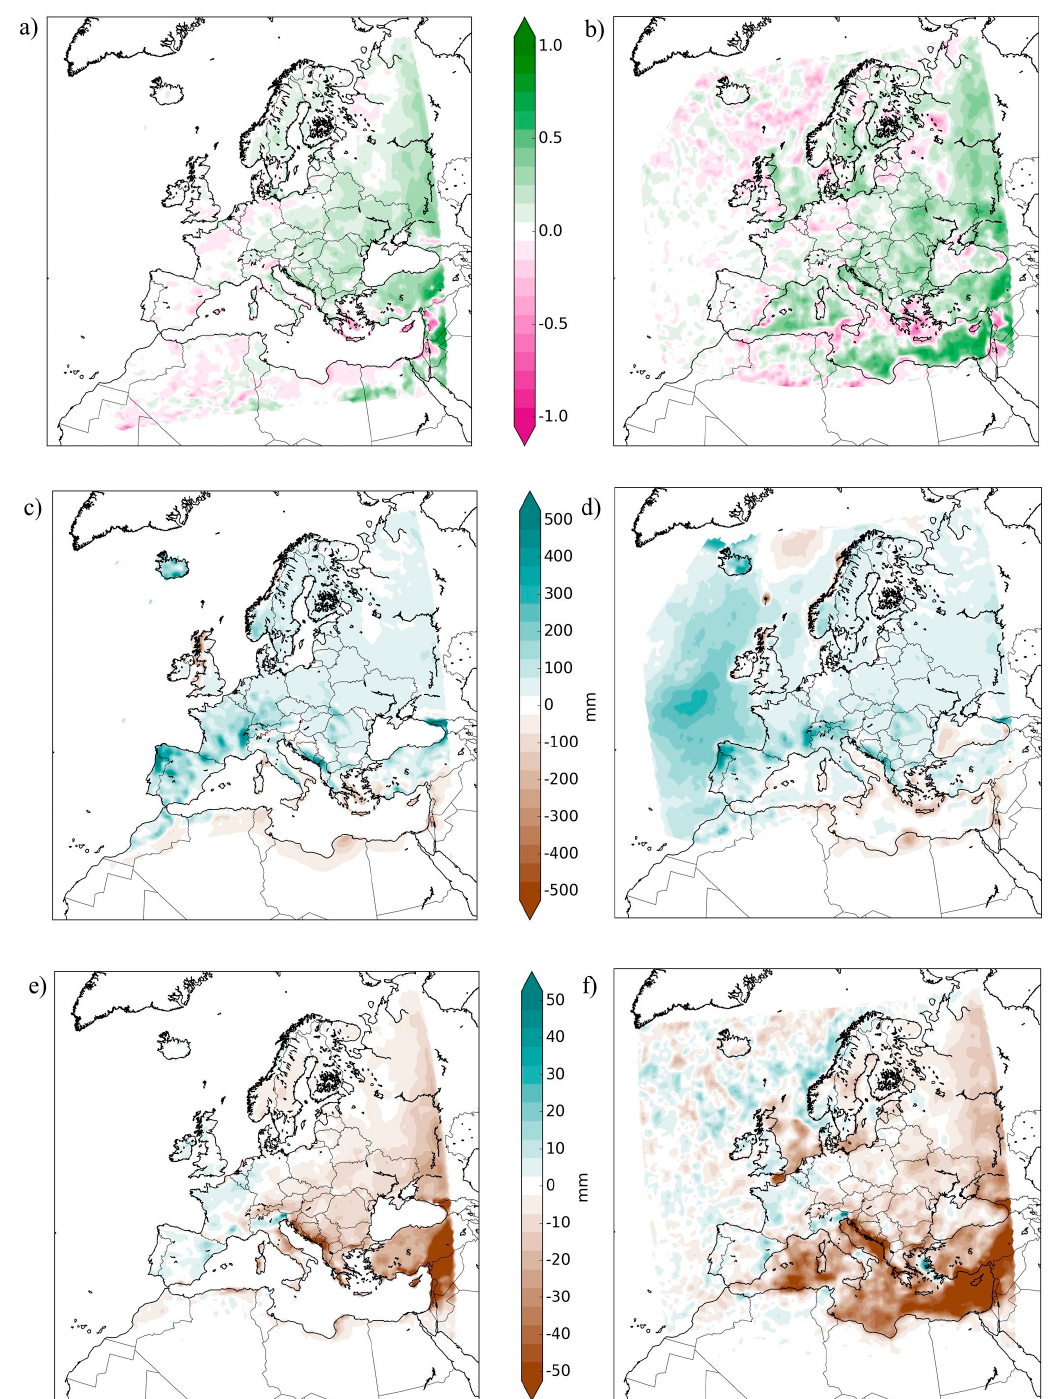
Figure 4. Mean winter precipitation sum: ( a ) Mean square error skill score (MSESS) values comparing the coupled system to the uncoupled with respect to CRU (Climatic Research Unit) (1901–2009) and ( b ) with respect to HOAPS/GPCC (Hamburg Ocean Atmosphere Parameters and Fluxes from Satellite Data, Global Precipitation Climatology Centre) (1988–2008), ( c ) bias of the coupled system with respect to CRU and ( d ) HOAPS/GPCC, ( e ) difference between the coupled and the uncoupled system for the time period 1901–2009 and for ( f ) 1988–2008.